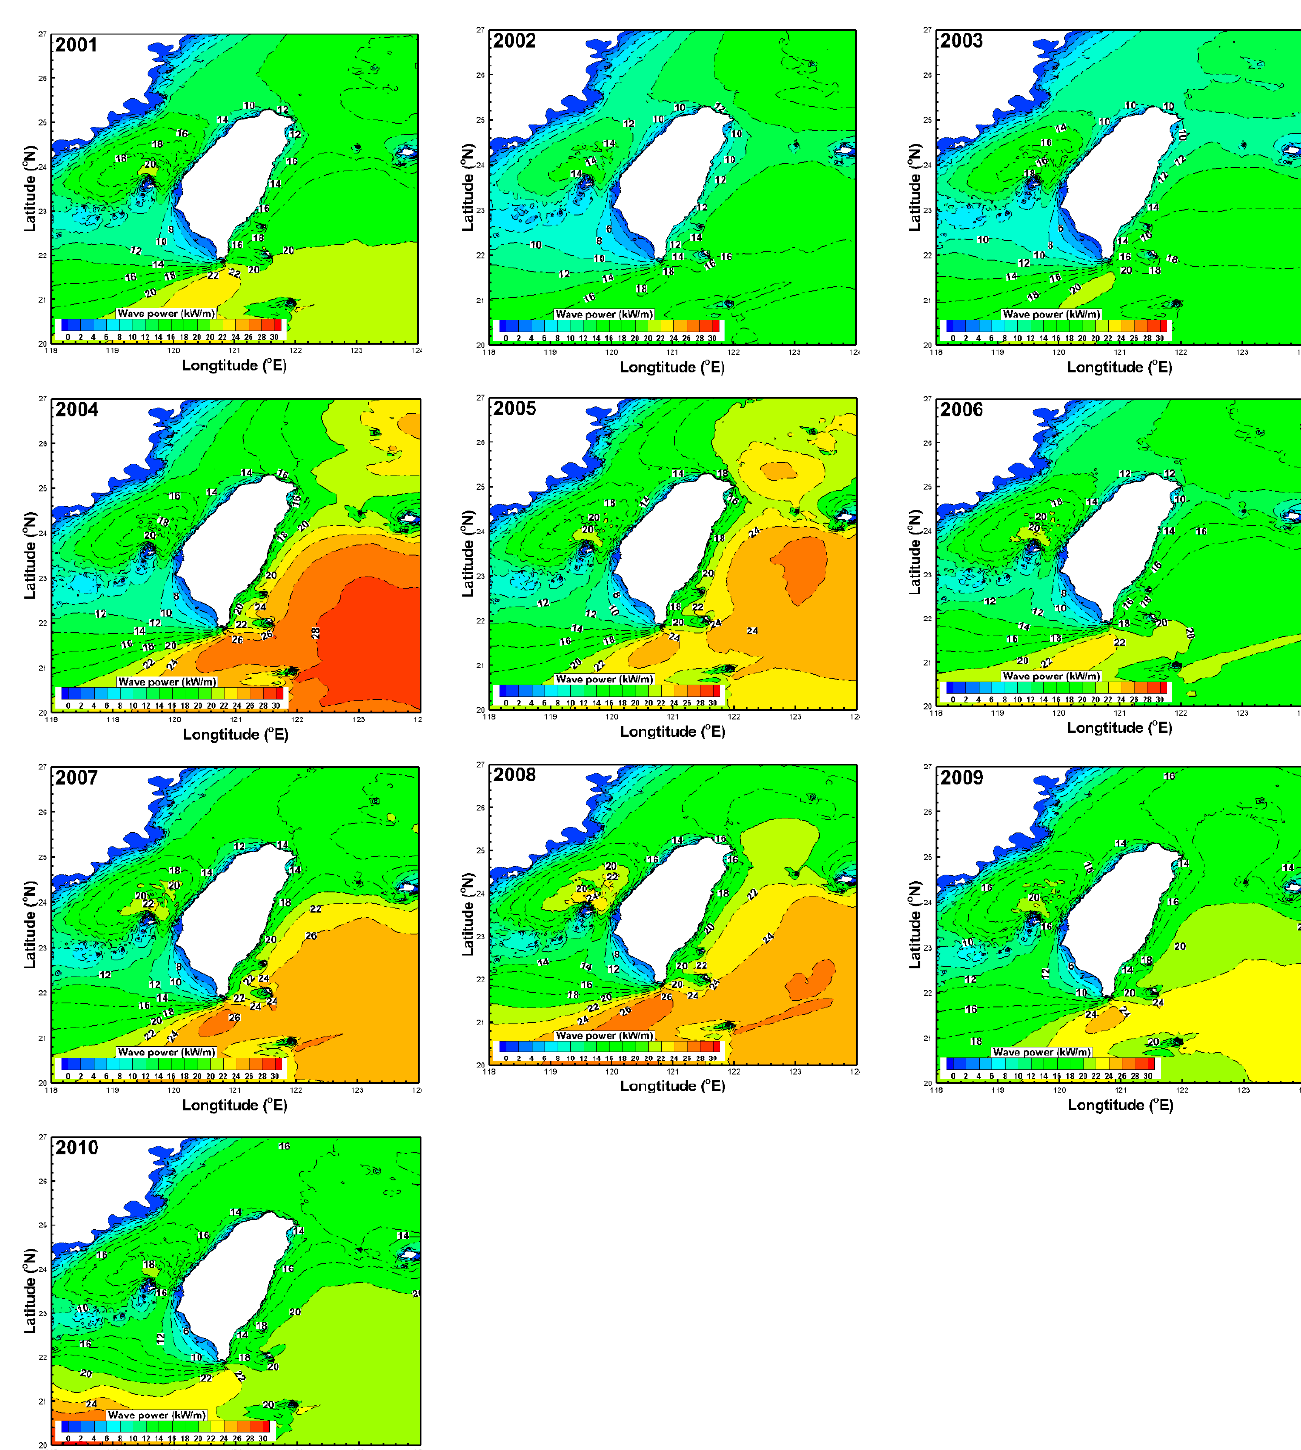
Figure 8. Spatial distributions of the annual average wave power in the offshore waters of Taiwan from 2001 to 2010.